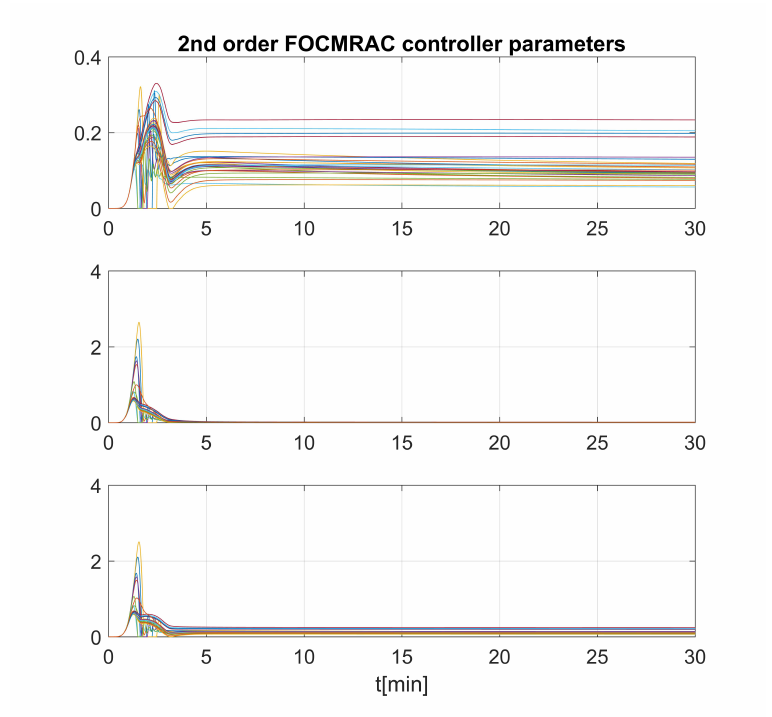
Figure 14. Controller parameters of the FOCMRAC scheme using the 2nd-order structure.